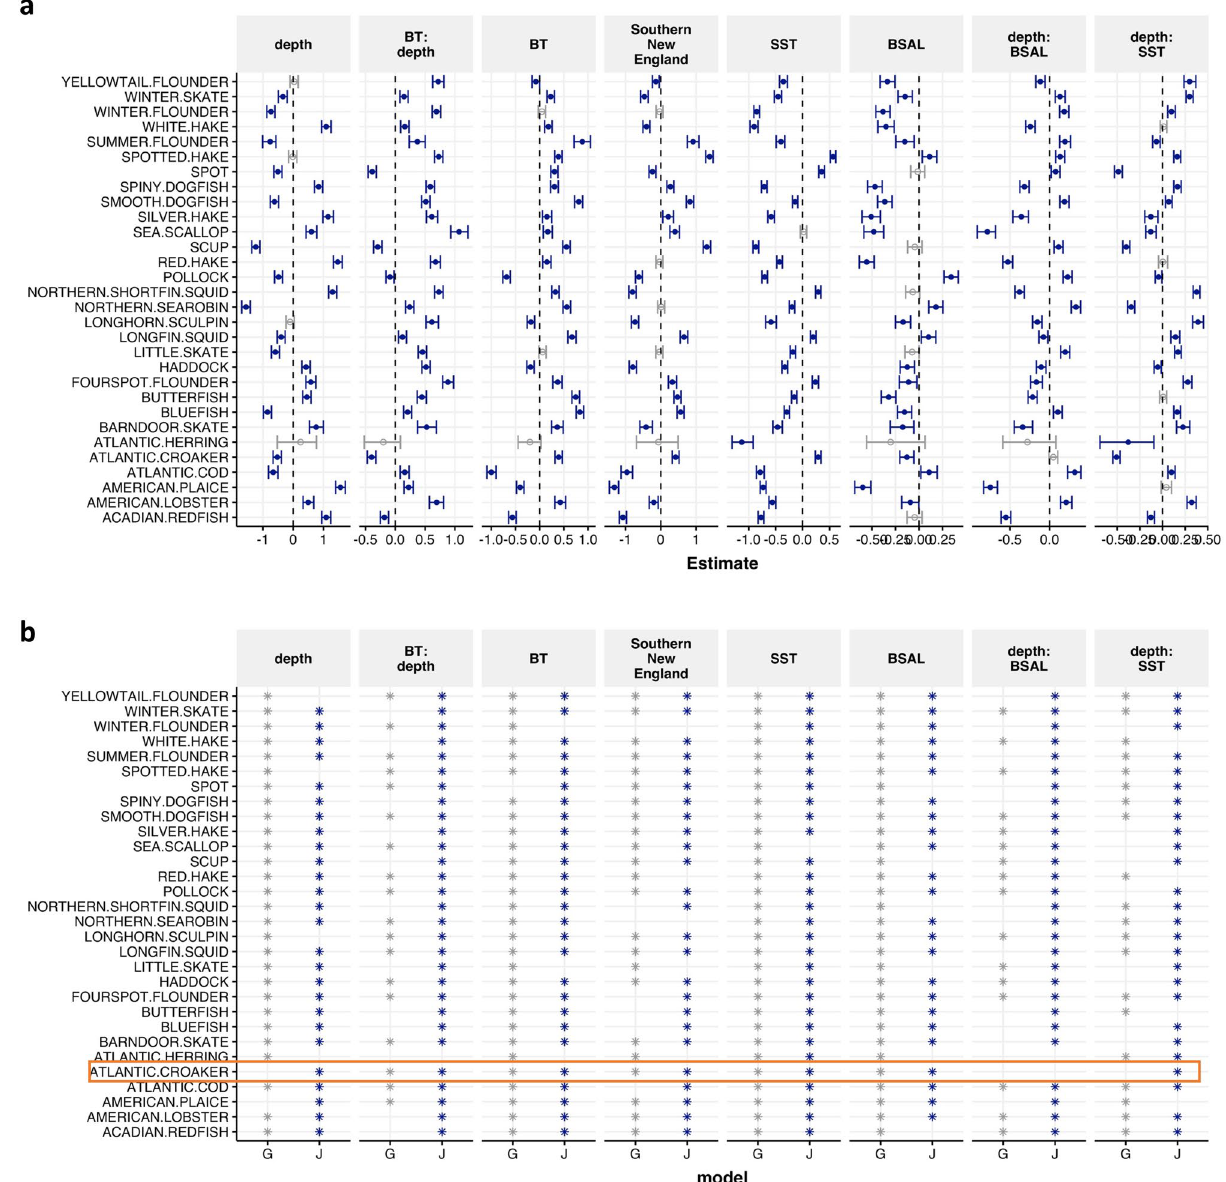
Figure 4. Beta sensitivities for individual species CPUE in the fall. Sensitivity of each species to beta parameters and estimated 95% credible intervals determined from GJAM model ( a ). Comparison of significant covariates in GAM (grey, G) versus GJAM (blue, J) models ( b ). Atlantic croaker is highlighted in